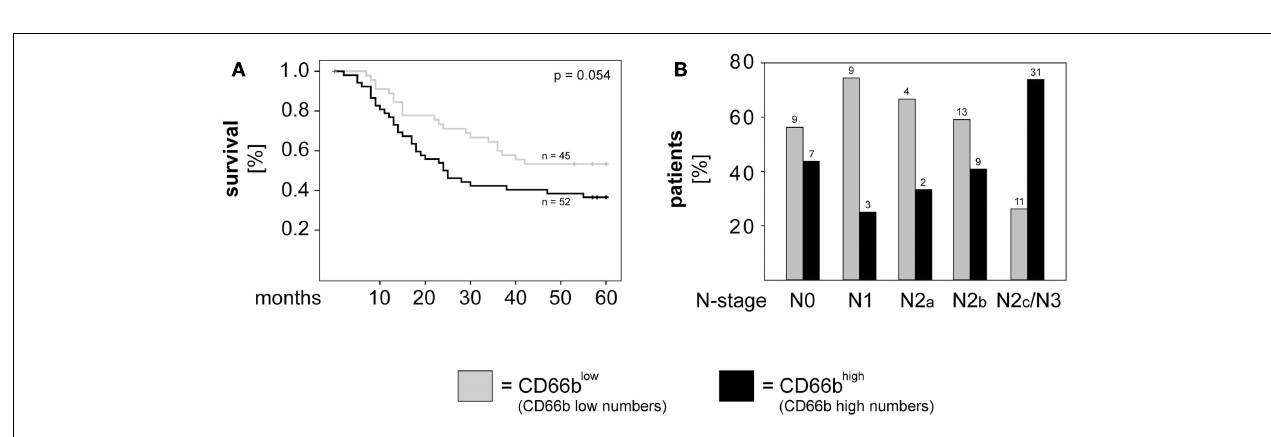
performed with the χ 2 test ( p = 0.005 for N1 versus N2c/N3; p = 0.015 for N2b versus N2c/N3; p = 0.001 for N unilateral versus bilateral). Patients with high numbers of infiltrating neutrophils (CD66b high ) are depicted in black, while patients with low numbers of infiltrating neutrophils (CD66b low ) are depicted in gray.The absolute patient numbers are indicated above each bar of the graphs.